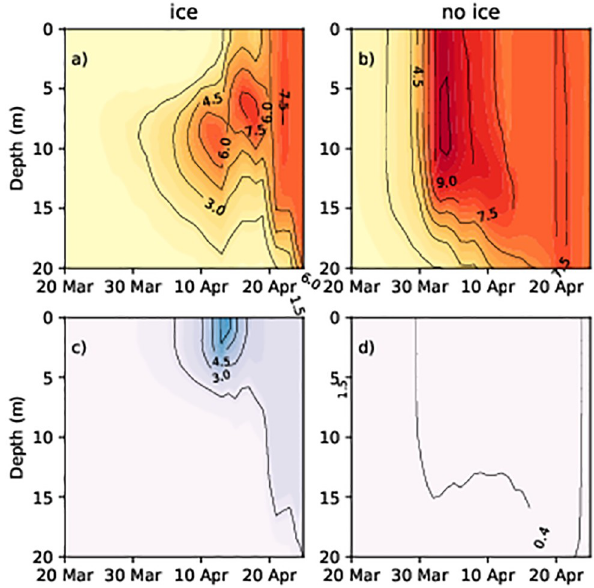
Fig 7. Diatom and flagellate concentrations (Chl mg/m 3 ) at station G1 in spring 2013. (a) Diatoms (no ice run); (b) diatoms (ice run); (c) dinoflagellates (no ice run); (d) dinoflagellates (ice run).